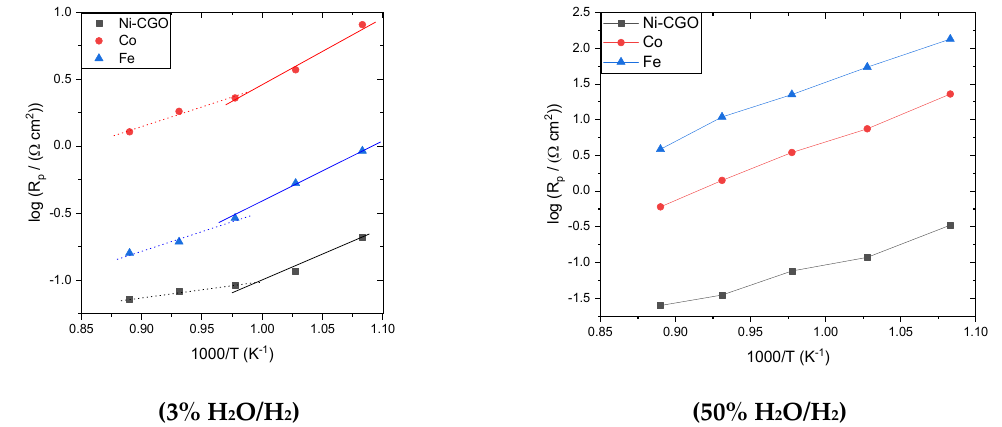
Figure 5. Bode plot from Fe-infiltrated LSCTZ5 at different temperatures in ( a ) 3% H 2 O/H 2 and ( b ) 50% H 2 O/H 2 .